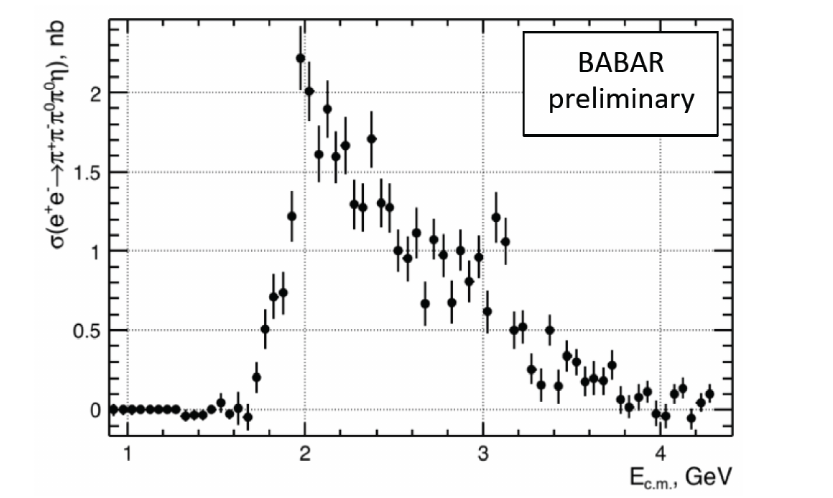
Figure 10. The measured e + e − → π + π − π 0 π 0 η cross section.